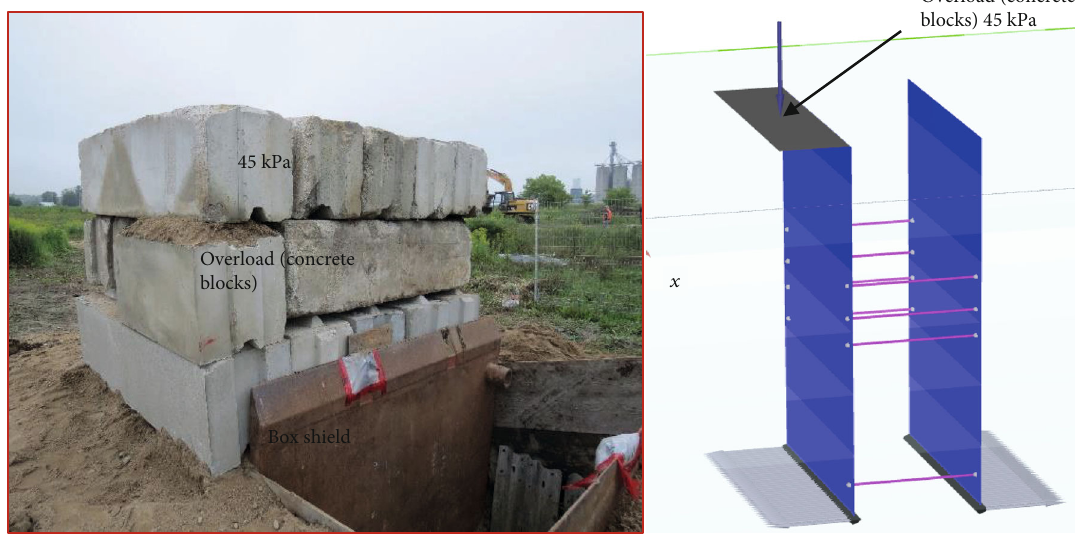
Figure 10: PLAXIS-3D simulation for the construction step 4 (phase 4) with overloading as per experimental site. Table 6: Soil pressure for di ff erent depths of excavation by the PLAXIS-3D MC model without MRF (option B ) compared with experimental. Depth from top